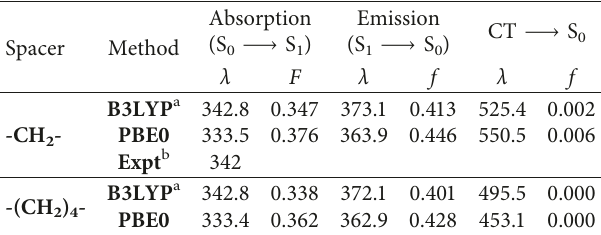
Reference [17]. b Reference [8]. Experimental data are also given.